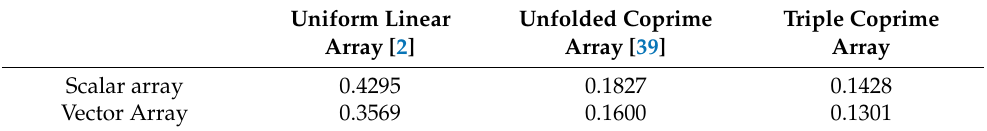
Table 1. Coupling leakage of different array